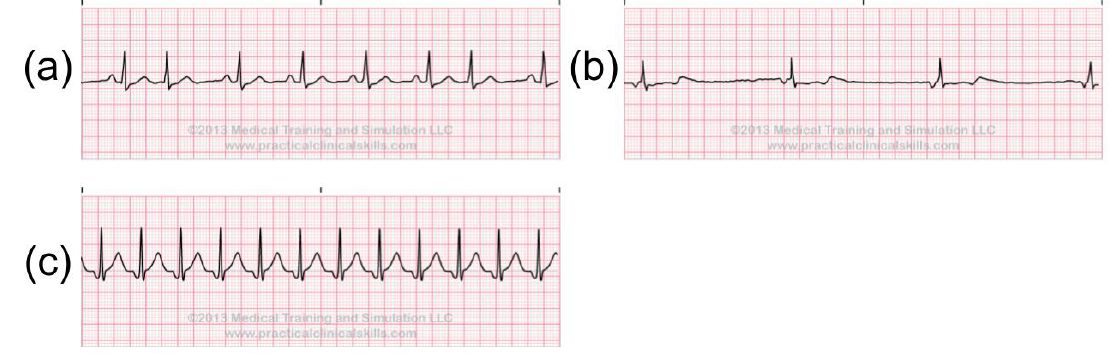
Figure 6. Abnormal Junctional Rhythms: ( a ) Premature Junctional Contraction, ( b ) Junctional Escaped Rhythm, ( c ) Junctional Tachycardia [21].